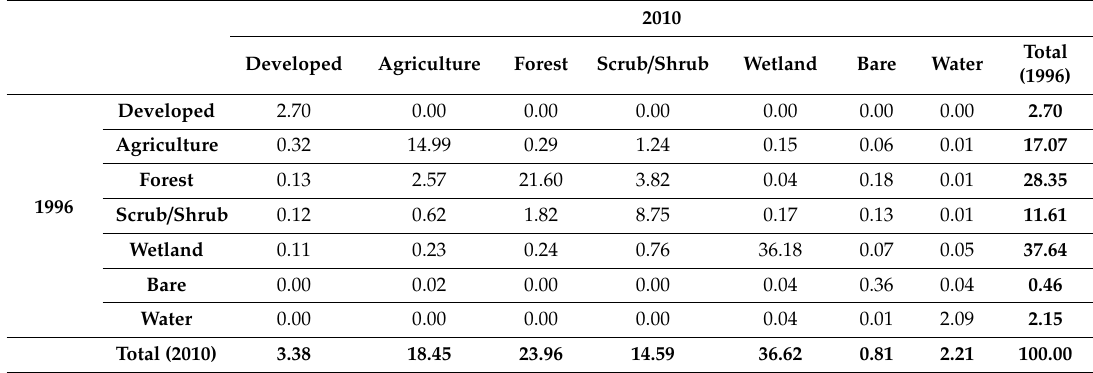
Table 5. Land Cover Change Matrix (in percent): 1996–2010. (Data source: C-CAP).